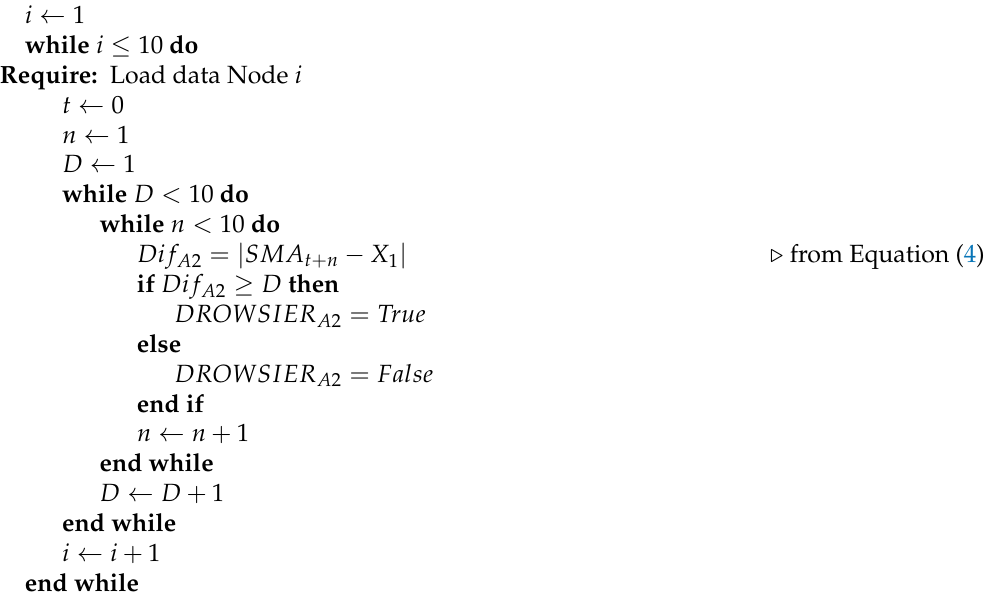
Algorithm 2 Pseudocode algorithm for testing the parameters of SMA algorithm— A